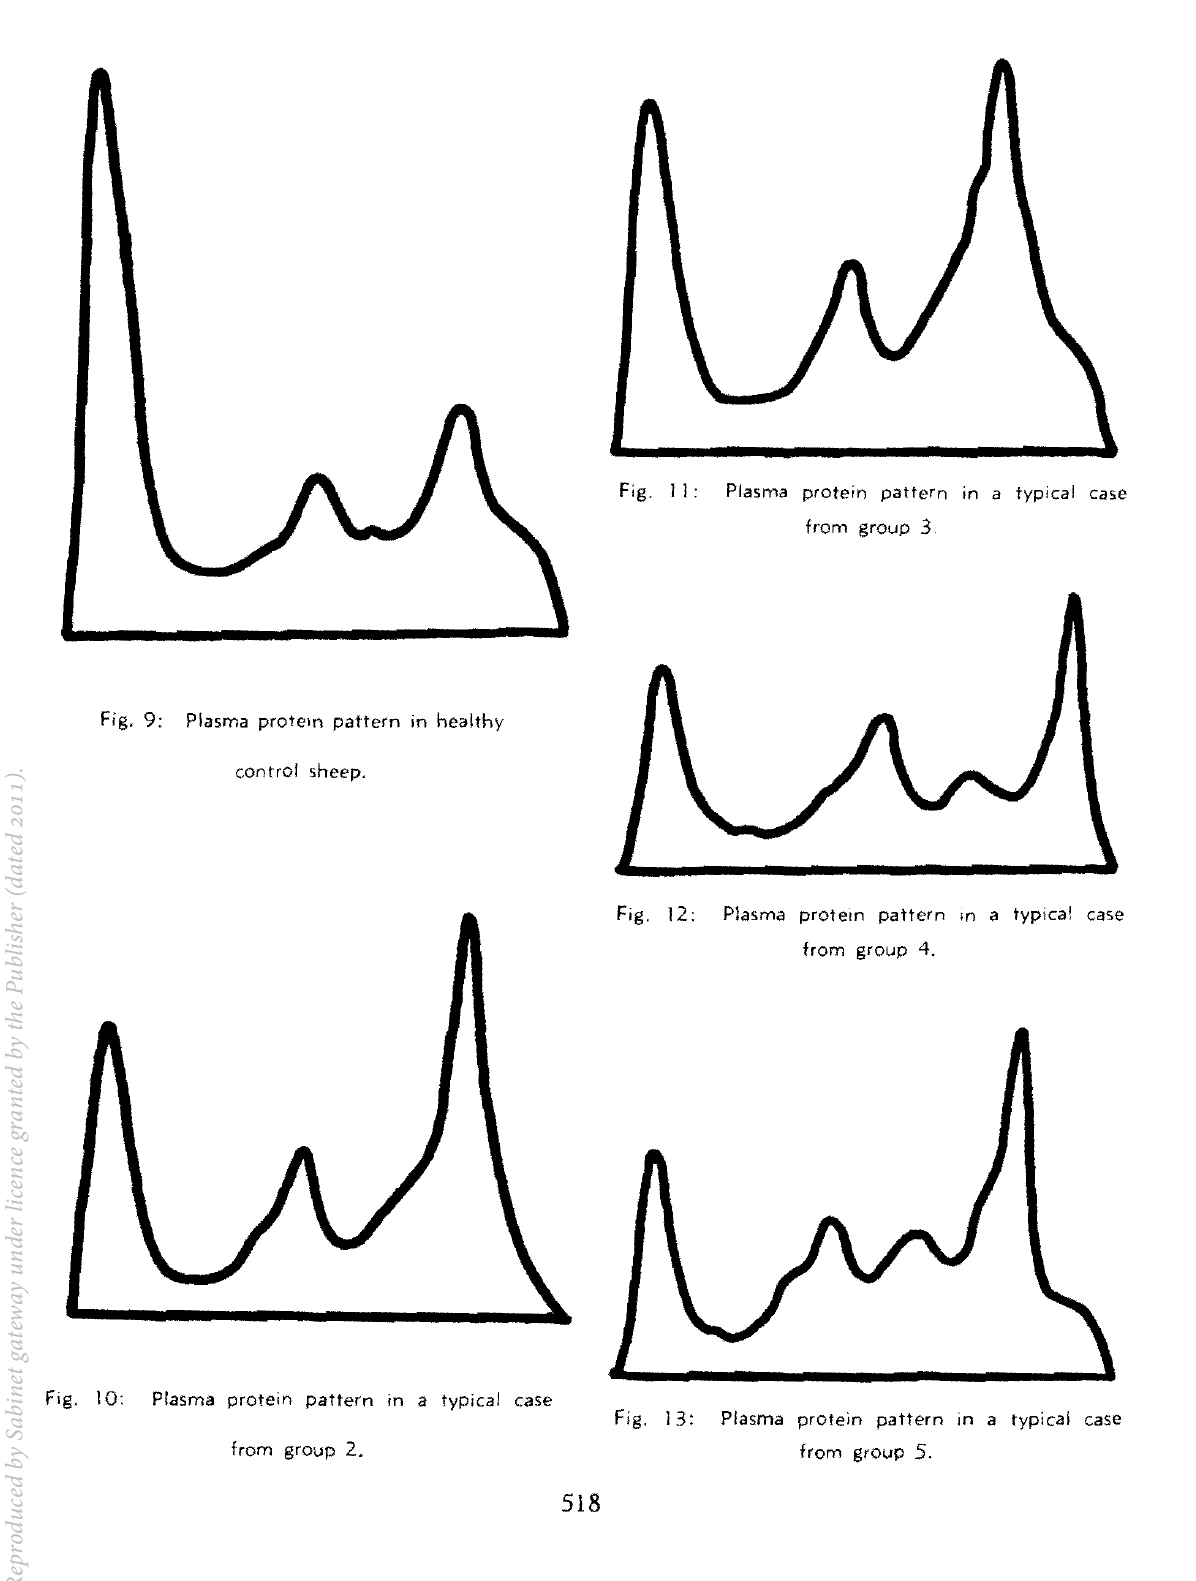
Fig. 13: Plasma protein pattern in a typical case from group 518